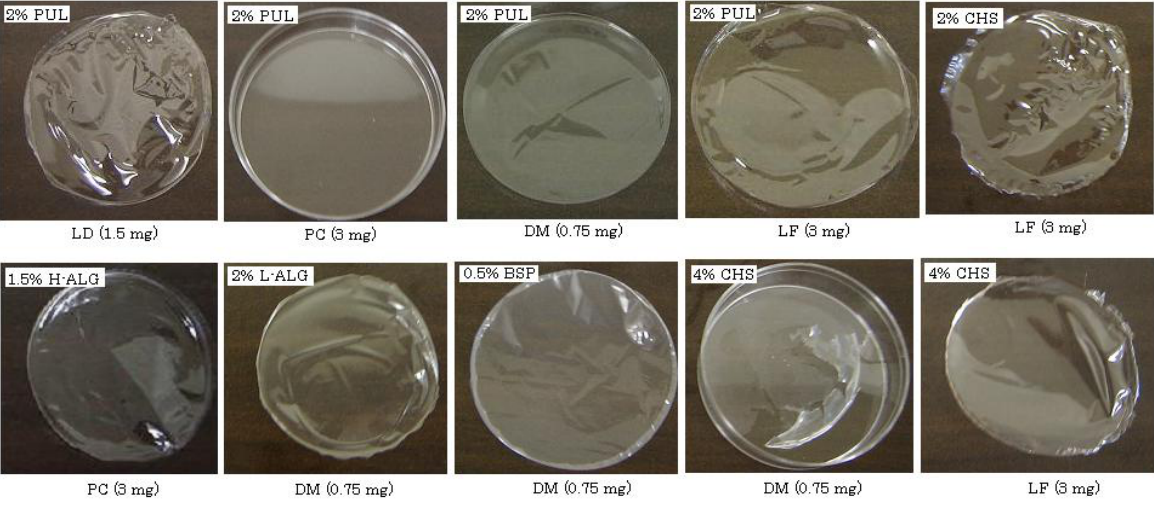
Figure 2. Surface structure of FDFs observed using a three-dimensional